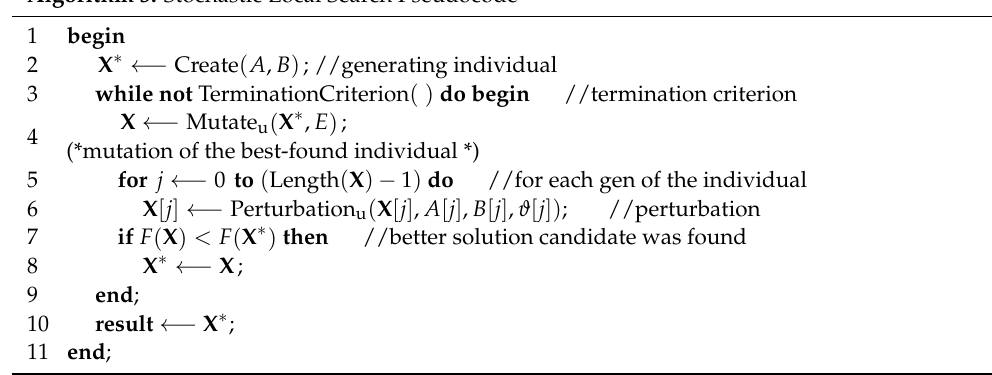
Algorithm 3: Stochastic Local Search